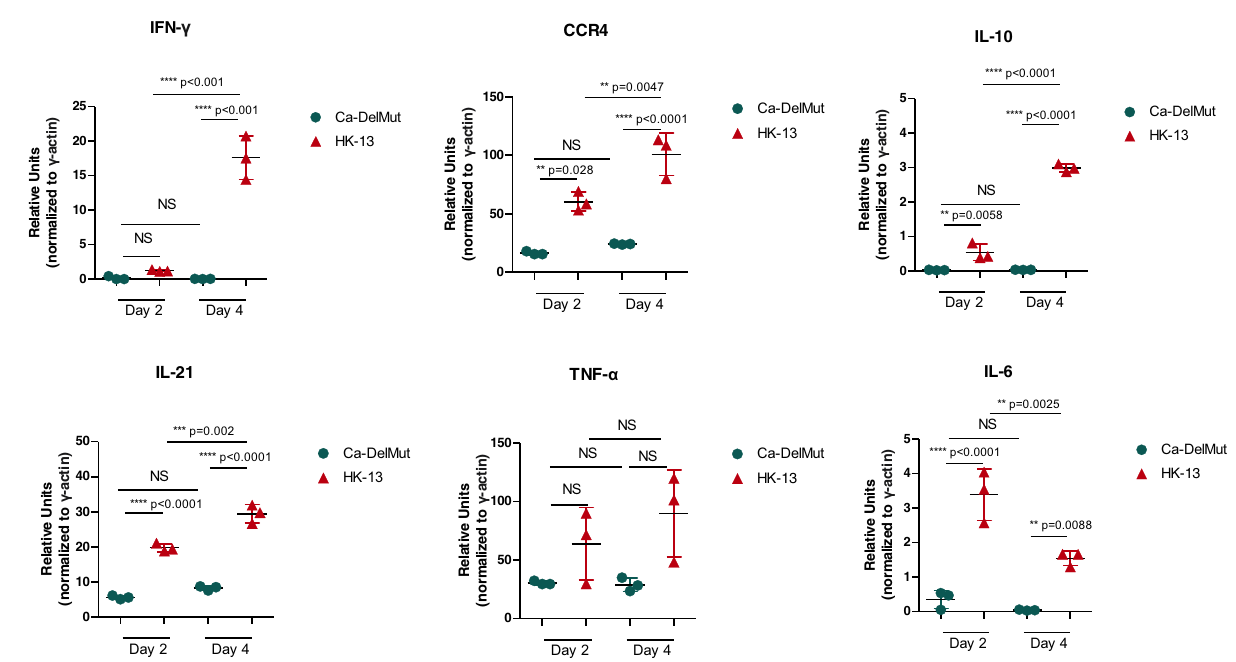
Fig. 3 Proin fl ammatory cytokine response pro fi les in Ca-DelMut- and wild-type-virus-infected hamsters. Hamsters were infected intranasally with 1 × 10 3 pfu of either Ca-DelMut ( n = 9) or WT HK-13 virus ( n = 9). At days 2 and 4, RNA was extracted from lung tissues of infected hamsters ( n = 3) and cDNA synthesized using oligo dT primers. Expression of different proin fl ammatory cytokines was examined by qPCR; relative mRNA levels (relative units) are normalized to an internal reference gene (hamster γ -actin), and the comparative Ct (2- ΔΔ Ct) method utilized to calculate the cytokine expression pro fi le. Statistical comparisons between means were performed by one-way ANOVA with Tukey post-test: **** p < 0.0001, *** p < 0.001, ** p < 0.01, * p < 0.05, NS: not signi fi cant.